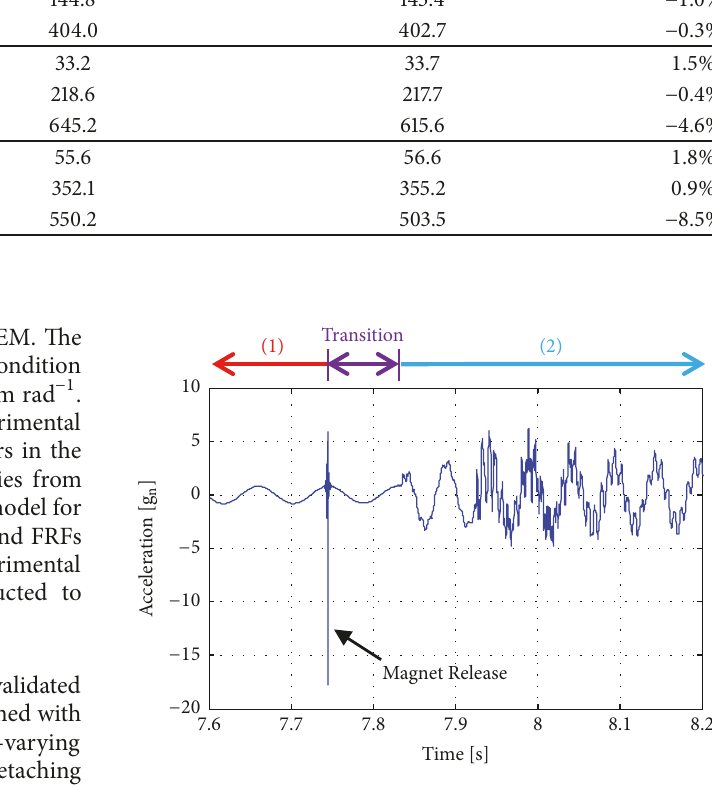
Figure 4: Detailed view of tip acceleration after the mass releases from the beam. There is a transition period between the beam in the first configuration (1) and the second configuration (2)